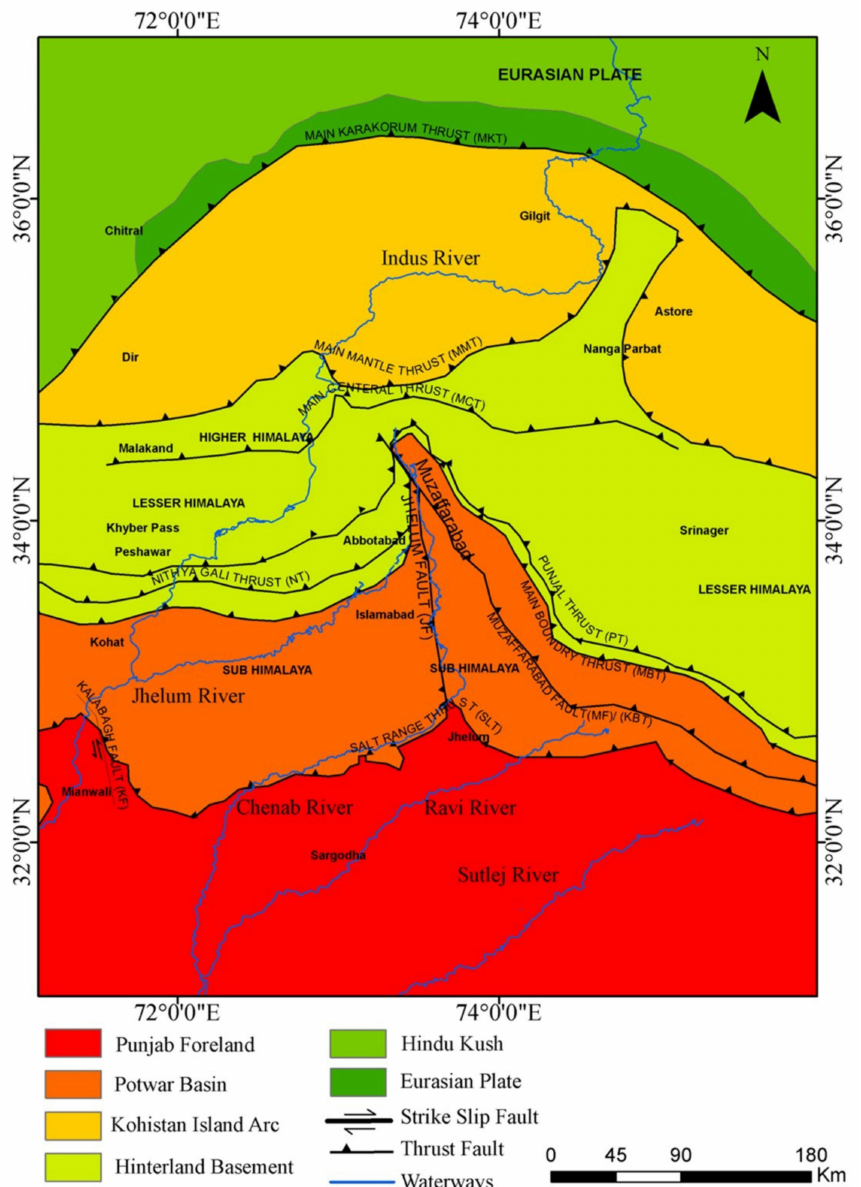
Figure 2. Tectonic map showing the main structural features in the northern area of